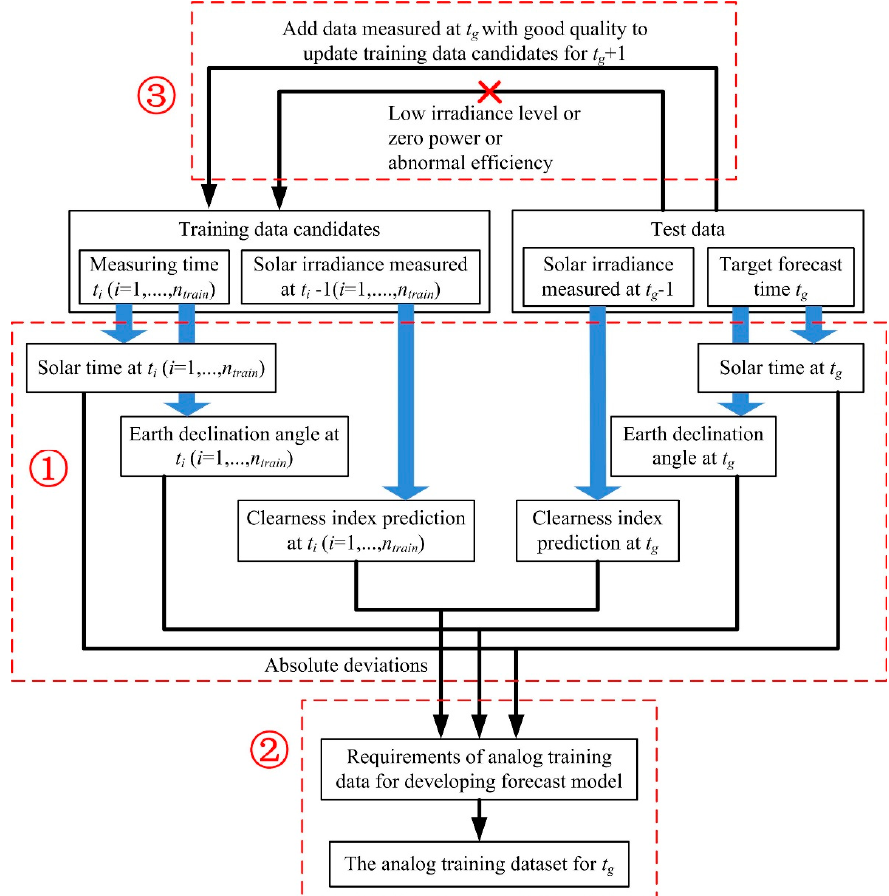
Figure 4. Steps of the proposed analog approach.